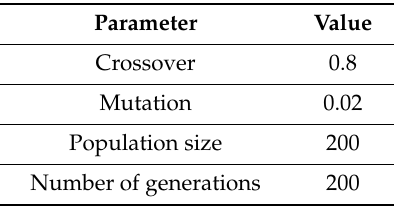
Table 6. Parameters of the genetic algorithm (GA).